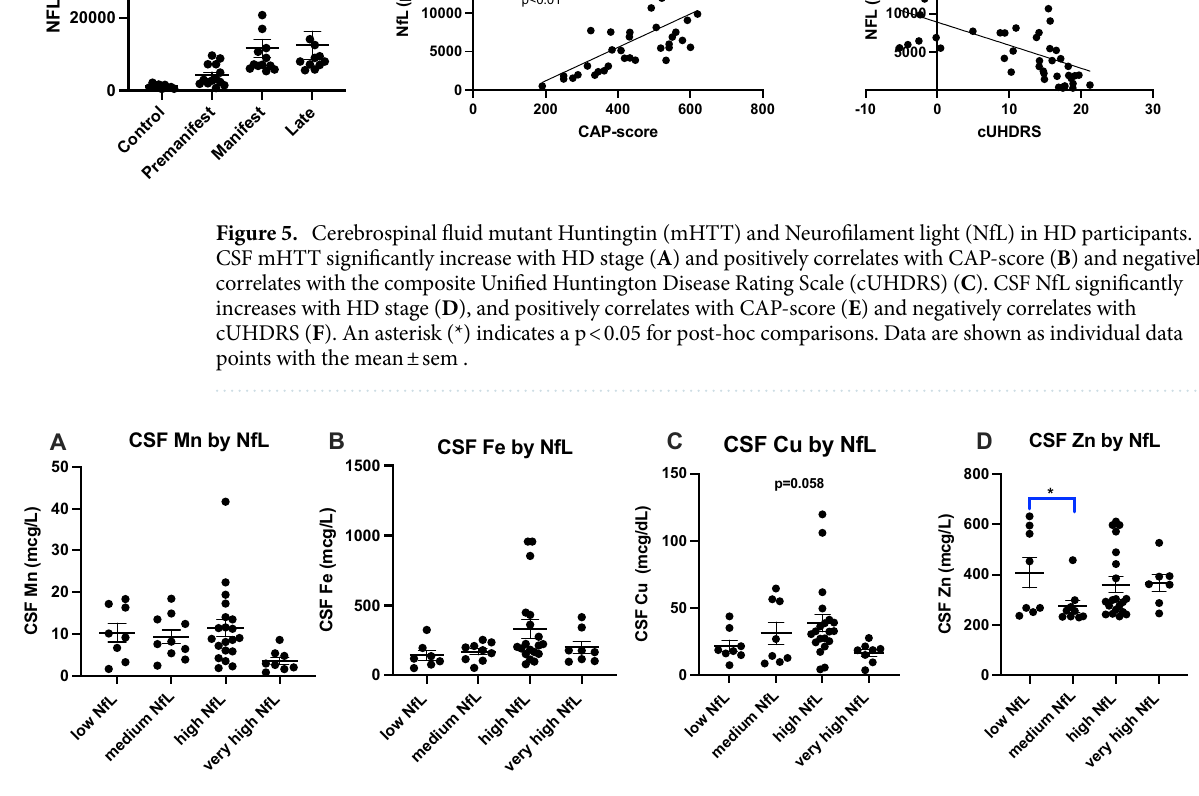
Figure 6. Cerebrospinal fluid ( A ) Mn, ( B ) Fe, ( C ) Cu and ( D ) Zn by Neurofilament light (NfL) in HD participants. NfL was categorized into low (0–1500 pg/mL), medium (1501–5000 pg/mL), high (5001– 10,000 pg/mL) and very high (10,000 + pg/mL). Differences in CSF metal level by NfL accumulation was assessed using 1-way ANOVA with post-hoc testing after determination of a significant (p < 0.05) main effect. An asterisk (*) indicates significant (p < 0.05) two-way comparison. Data are shown as individual data points with the mean ±